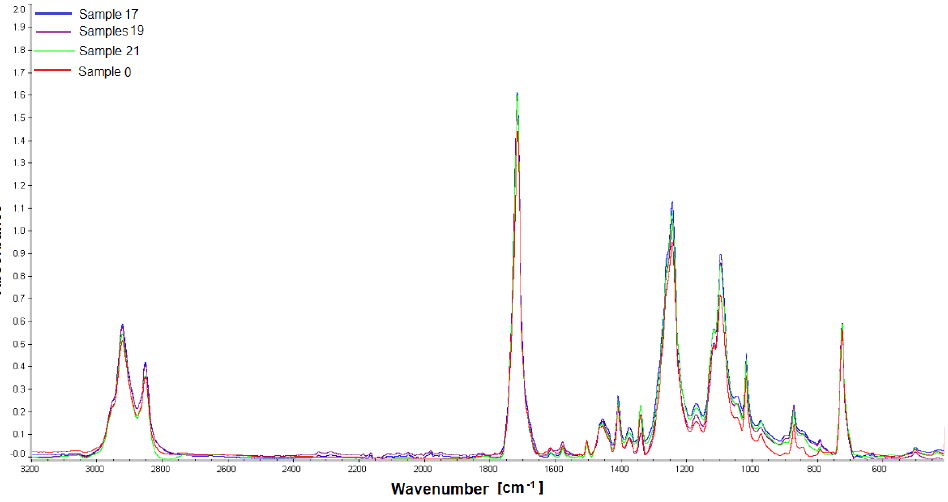
Figure 8. FTIR spectra of the studied PET-DLA 65 copolymers: sample 0-not implanted, sample 17, 19, 21 after 12-week implantation period.